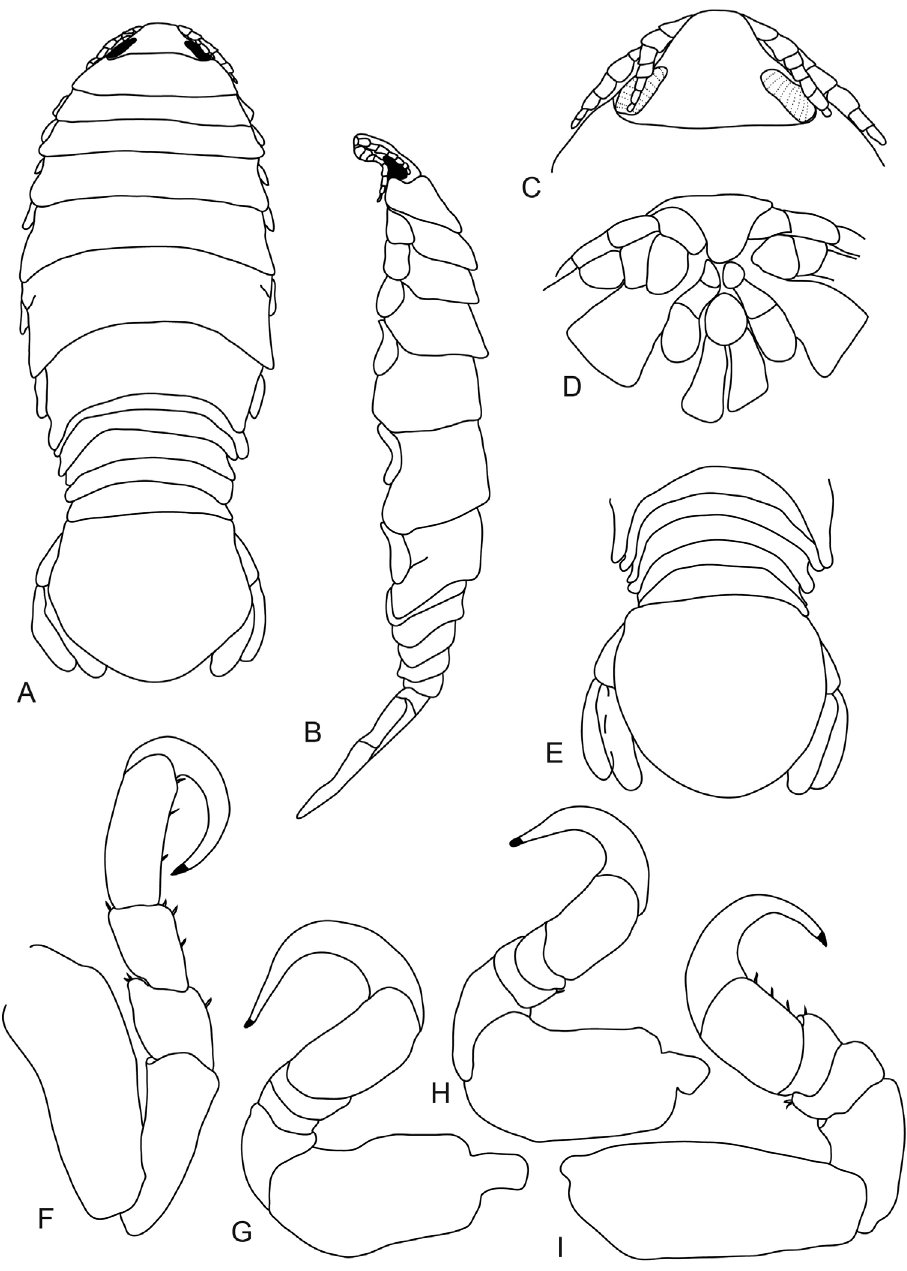
Figure 1. Anilocra haemuli female (29 mm) A–D Anilocra haemuli female (23 mm) E–I : A dorsal view B lateral view C dorsal view of cephalon D ventral view of cephalon. E dorsal pleotelson F pereopod 7 G pereopod 2 H pereopod 1 I pereopod